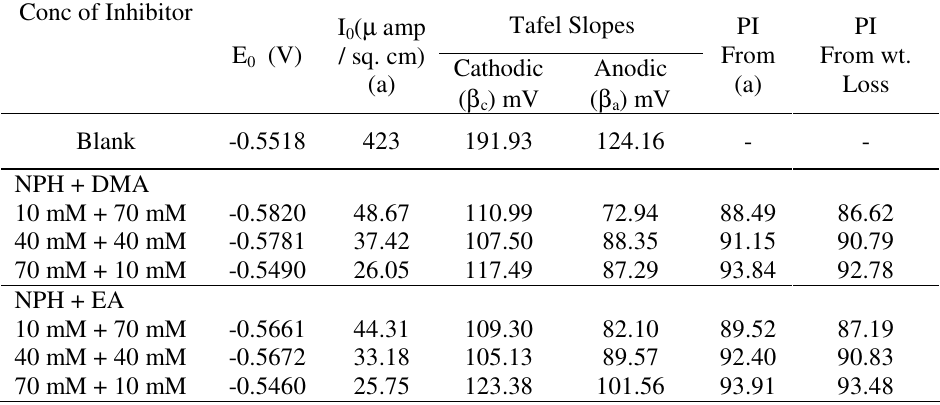
Table 5 . Electrochemical parameters in absence and in presence of the binary